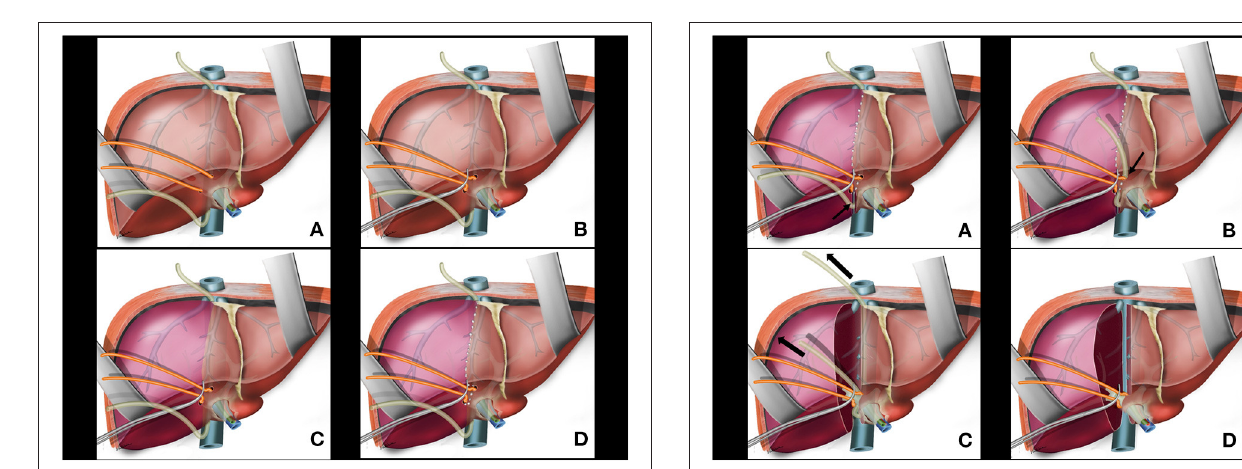
FIGURE 3 | (A) Glissonian pedicle retriever is withdrawn and the right glissonian pedicle is isolated by the rubber tube. (B) The rubber tube is pulled for occlusion of the isolated pedicle. (C) Ischemic delimitation of the right hepatic parenchyma is observed. (D) Ischemic transition line is demarcated with electrocautery.